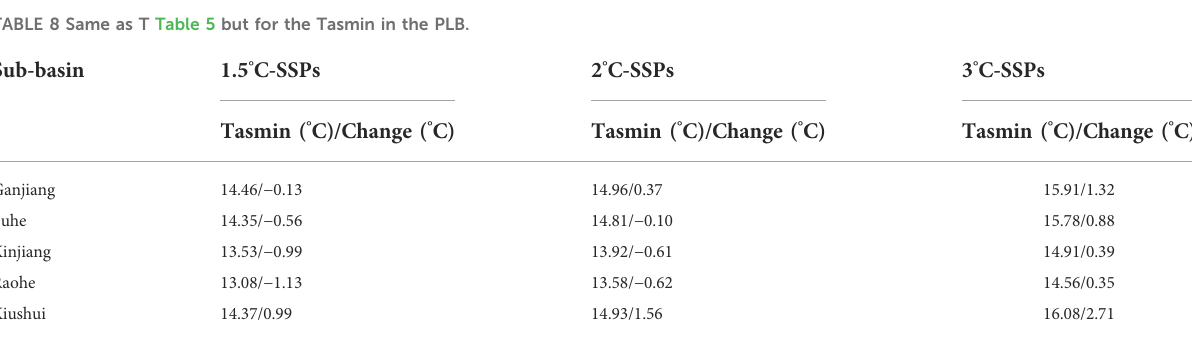
TABLE 8 Same as T Table 5 but for the Tasmin in the